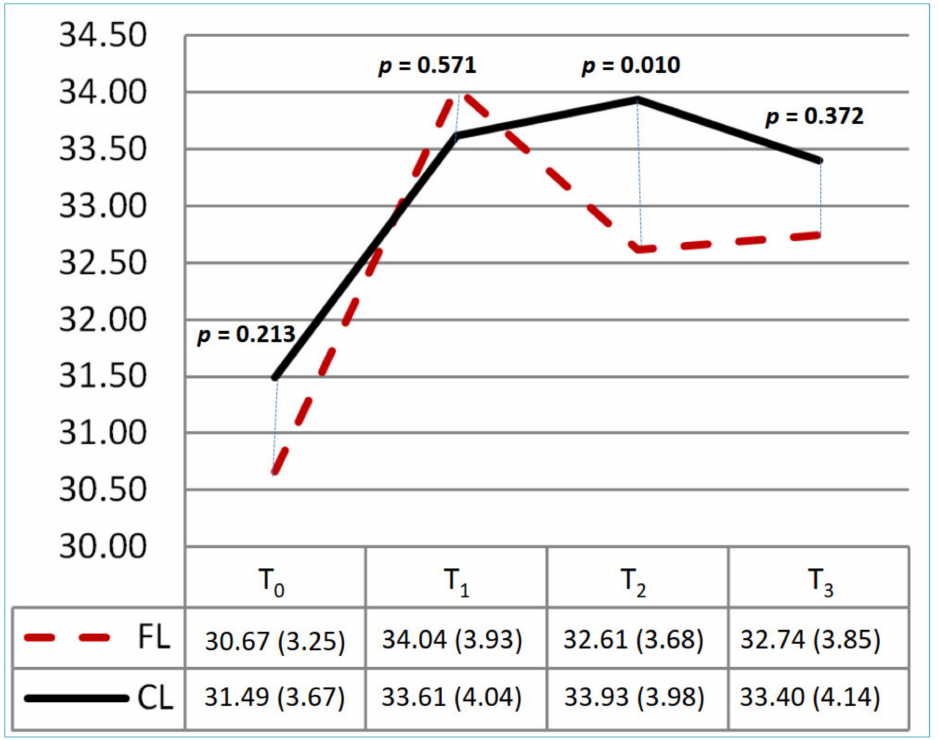
Figure 3. The change of attitude score between two groups at T 0 –T 3 . CL: conventional learning; FL: flipped learning. Total range: 10–40. T 0 : baseline; T 1 : immediately; T 2 : 1st month; T 3 : 3rd